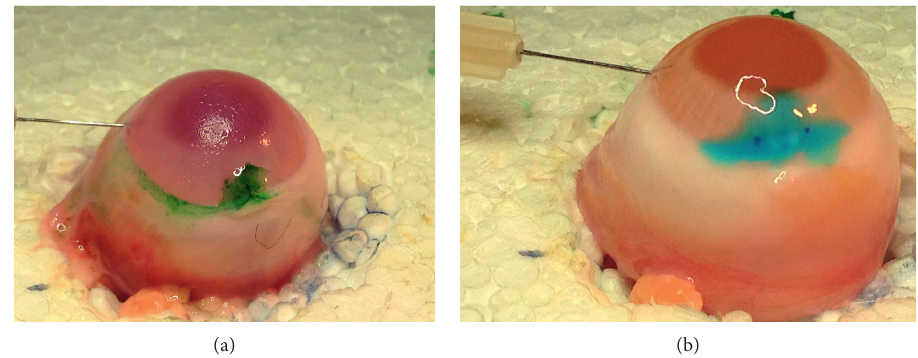
Figure 2: (a) A 10-0 nylon suture was placed on the main corneal wound. Indocyanine green was instilled on the wound to facilitate the identification of fluid egress. (b) Caliper marks are visible in this image. The wound was covered completely with ReSure